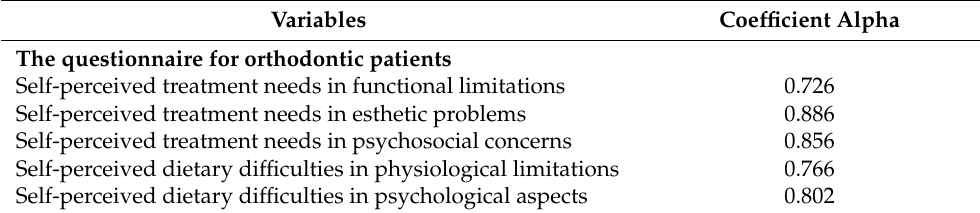
Table 2. Cronbach’s alpha of each construct of the PT questionnaire. Variables Coefficient